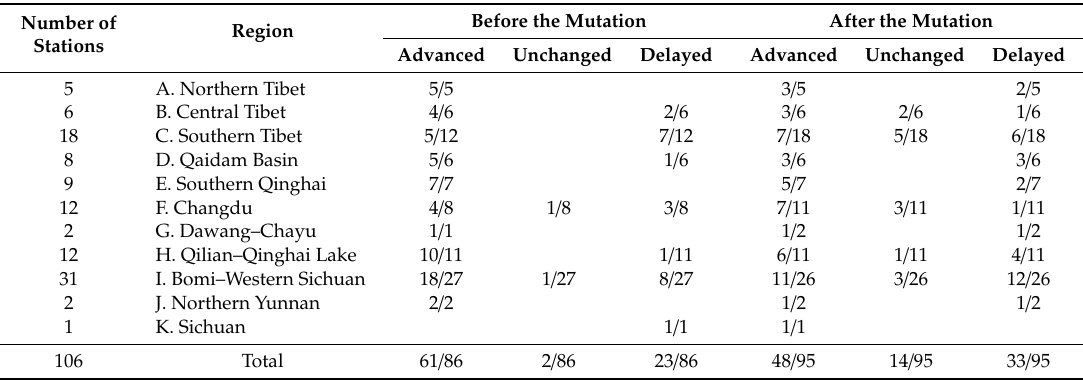
Table 2. The di ff erences in the regional trends in the rainy season onset before and after the mutation. Before the Mutation After the Mutation Number of Region Stations Advanced Unchanged Delayed Advanced Unchanged